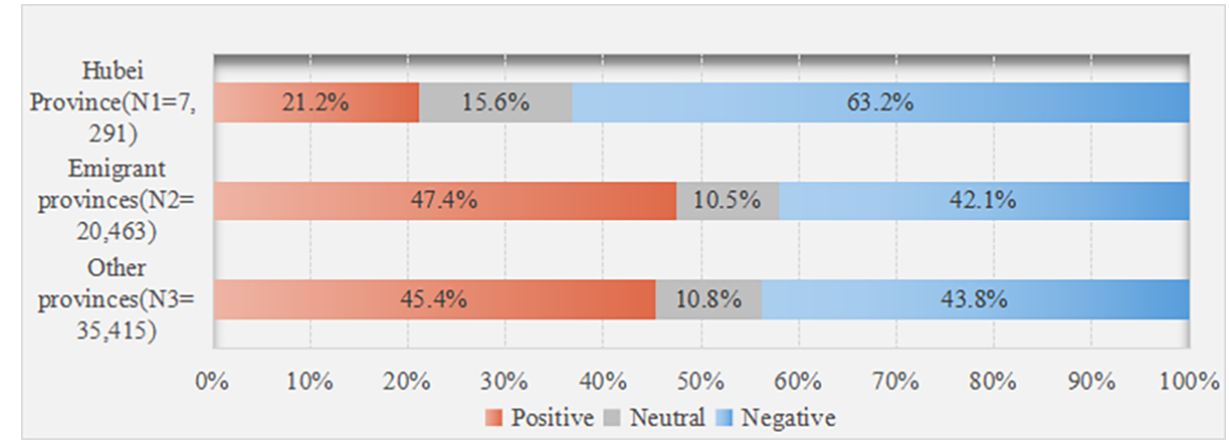
Figure 4. Proportion of users' emotional polarity from different spatial locations